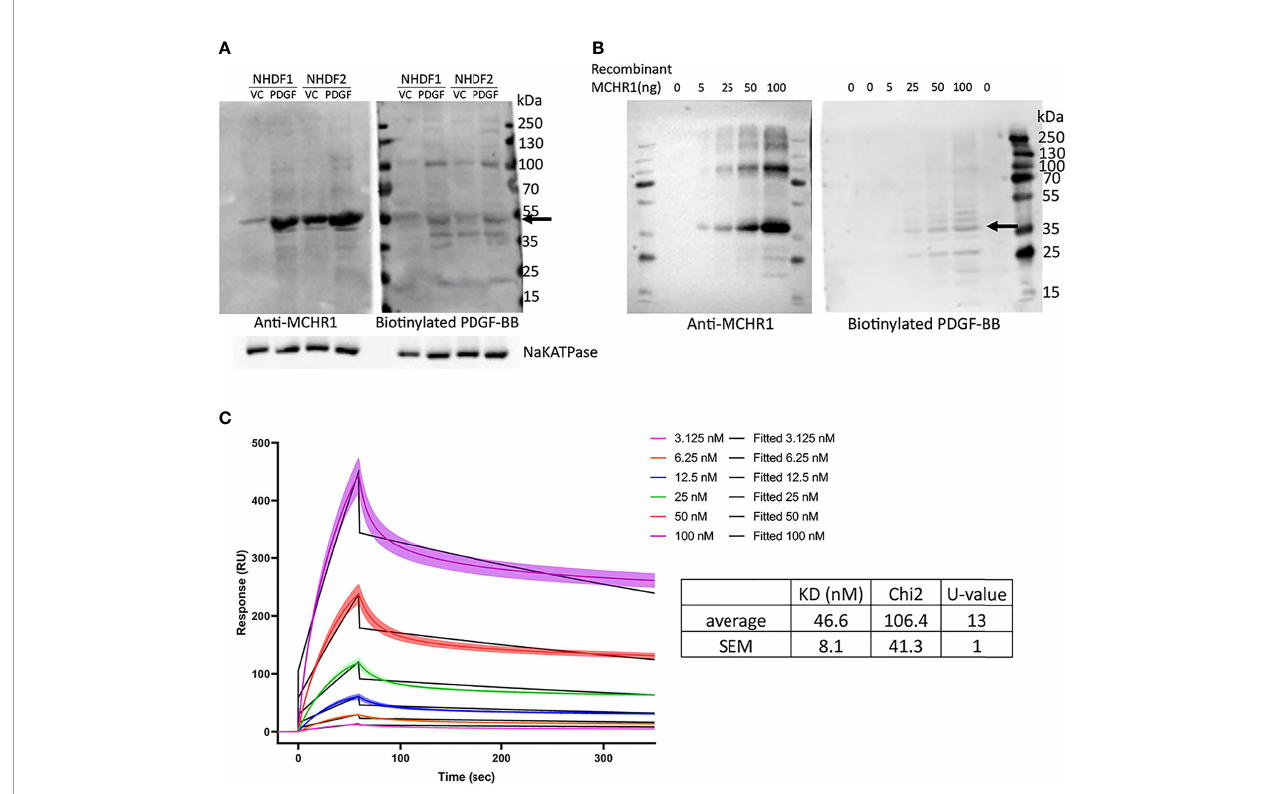
FIGURE 4 | PDGF-BB binding to MCHR1. (A) PDGF-BB binding to MCHR1 was assessed using biotinylated PDGF-BB in a western ligand blot. PDGF-BB (40ng/ml) or vehicle control-treated NHDF membrane fractions were separated by electrophoresis on the same gel. The gel was transferred to a membrane and the membrane was cut in half. MCHR1 was detected on one membrane using anti-MCHR1 antibody, and proteins interacting with PDGF-BB were detected on the second membrane using biotinylated PDGF-BB. The molecular weight of MCHR1 corresponds to the 50- to 55-kd bands indicated by arrows. (B) PDGF-BB binding to recombinant human MCHR1 was assessed using biotinylated PDGF-BB in a western ligand blot. The indicated amount of recombinant MCHR1 was separated by electrophoresis on the same gel. The gel was transferred to a membrane and the membrane was cut in half. MCHR1 was detected on one membrane using anti-MCHR1 antibody, and proteins interacting with PDGF-BB were detected on the second membrane using biotinylated PDGF-BB. The molecular weight of recombinant MCHR1 corresponds to the 35- to 45-kd bands indicated by arrows. (C) Surface plasmon resonance (SPR) measurements of PDGF-BB and recombinant MCHR1. Black lines represent the model data and colored lines show the response of PDGF-BB binding to MCHR1 over time. Recombinant MCHR1 was immobilized on the CM5 chip and the indicated concentrations of PDGF-BB were added. Kinetic values are the mean ± SEM from 3 independent experiments, each ran in